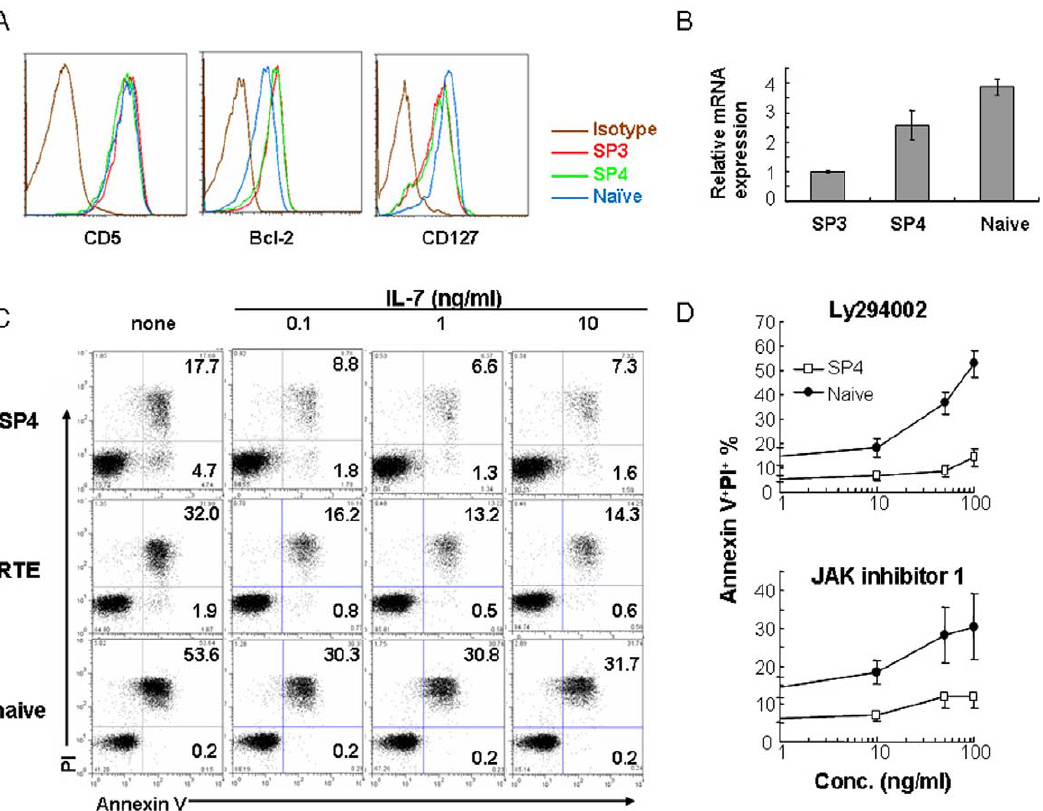
Figure 3. Comparison of the survival of pre-RTEs and naı¨ve T cells in tissue culture. (A) Phenotypic comparison of freshly isolated SP4 thymocytes and CD4 + naı¨ve T cells. SP3 thymocytes were used as a control. (B) Comparsion of Bim ( Bcl2l11 ) expression among SP3, SP4 thymocytes, and CD4 + naı¨ve T cells. Total RNAs were extracted from the three purified T cell populations. Reverse transcription and quantitative PCR was performed using Bim-specific primers. Asterisks indicate significant (*, p , 0.05; **, P , 0.01) changes compared between the two subsets by unpaired Student t test. (C) Purified SP4 thymocytes, RTEs and CD4 + naı¨ve T cells from lymph nodes of C57BL/6 mice were incubated without or with indicated concentrations of IL-7. Annexin V and PI staining of these T cells were analyzed 24 hours later. The numbers in the plot represent the percentage of Annexin V + PI + or Annexin V + PI - cells. The results were obtained from one of the three similar experiments. (D) Various concentrations of LY294002 and JAK inhibitor 1 were added to the T cell culture described in C. Annexin V and PI staining of these T cells were analyzed 24 hours later. The differences in the increase of Annexin V positive cells at 50 ng/ml of LY294002 and 100 ng/ml of JAK inhibitor I was significant (P , 0.05) when SP4 and naı¨ve T cells were compared by unpaired Student t